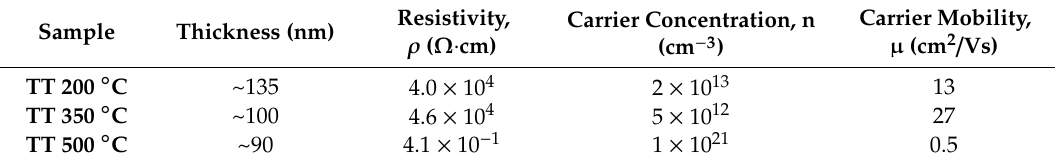
Table 1. Hall effect measurement results of CZTS thin films with different TT temperatures. Table 1. Hall e ff ect measurement results of CZTS thin films with di ff erent TT temperatures.